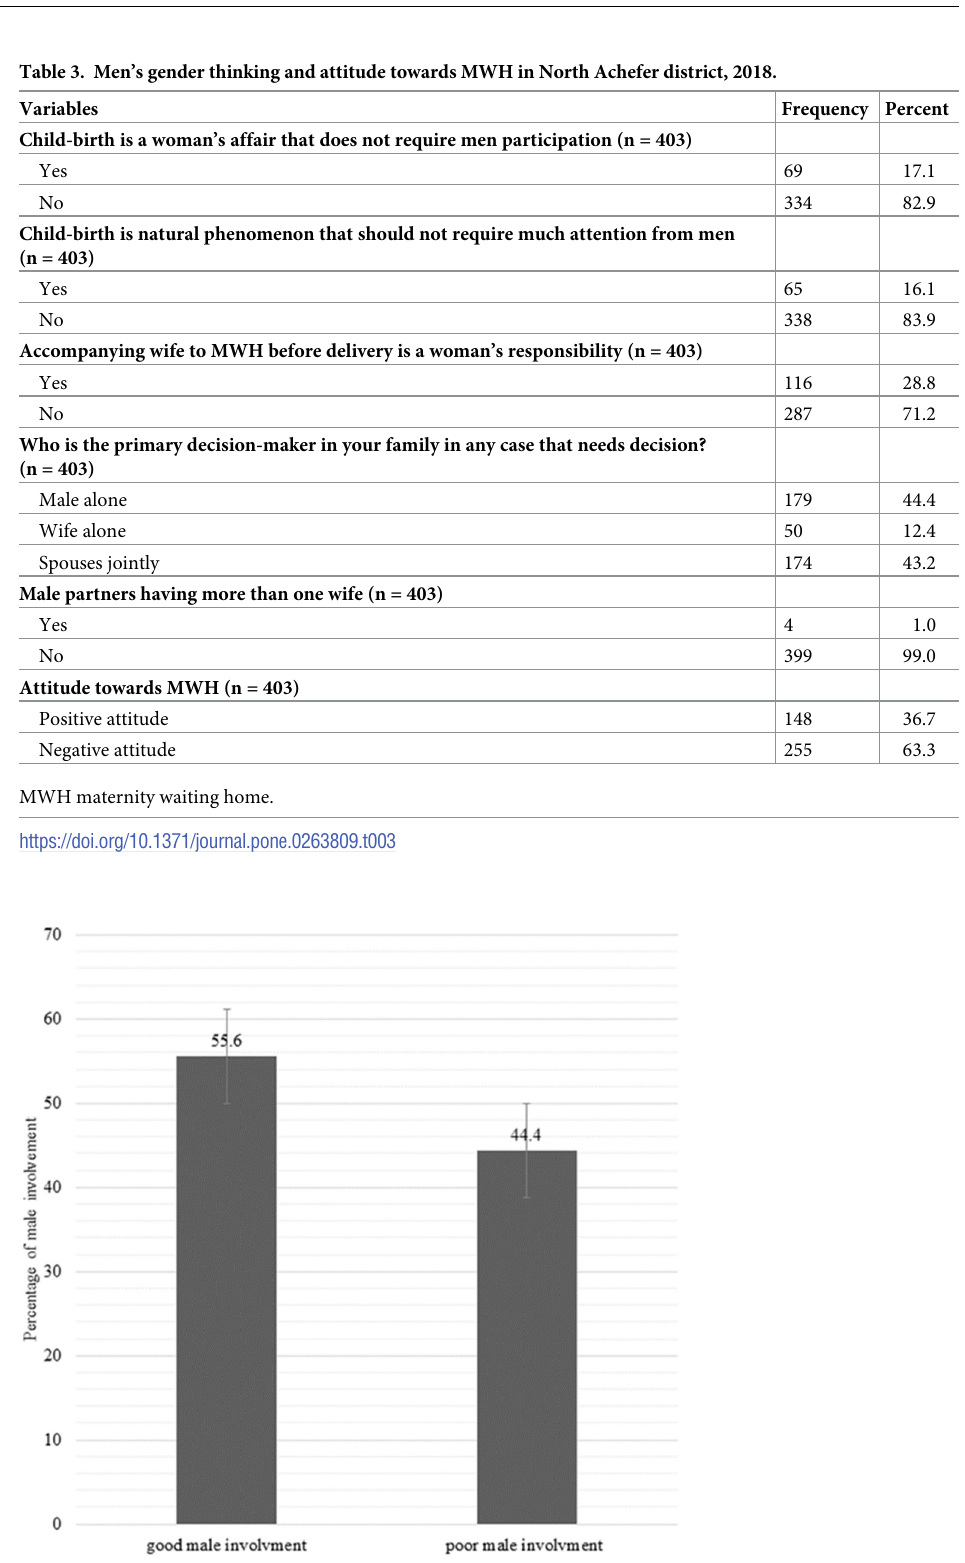
Fig 1. Overall men’s involvement in maternity waiting home utilization, North Achefer district, 2018.